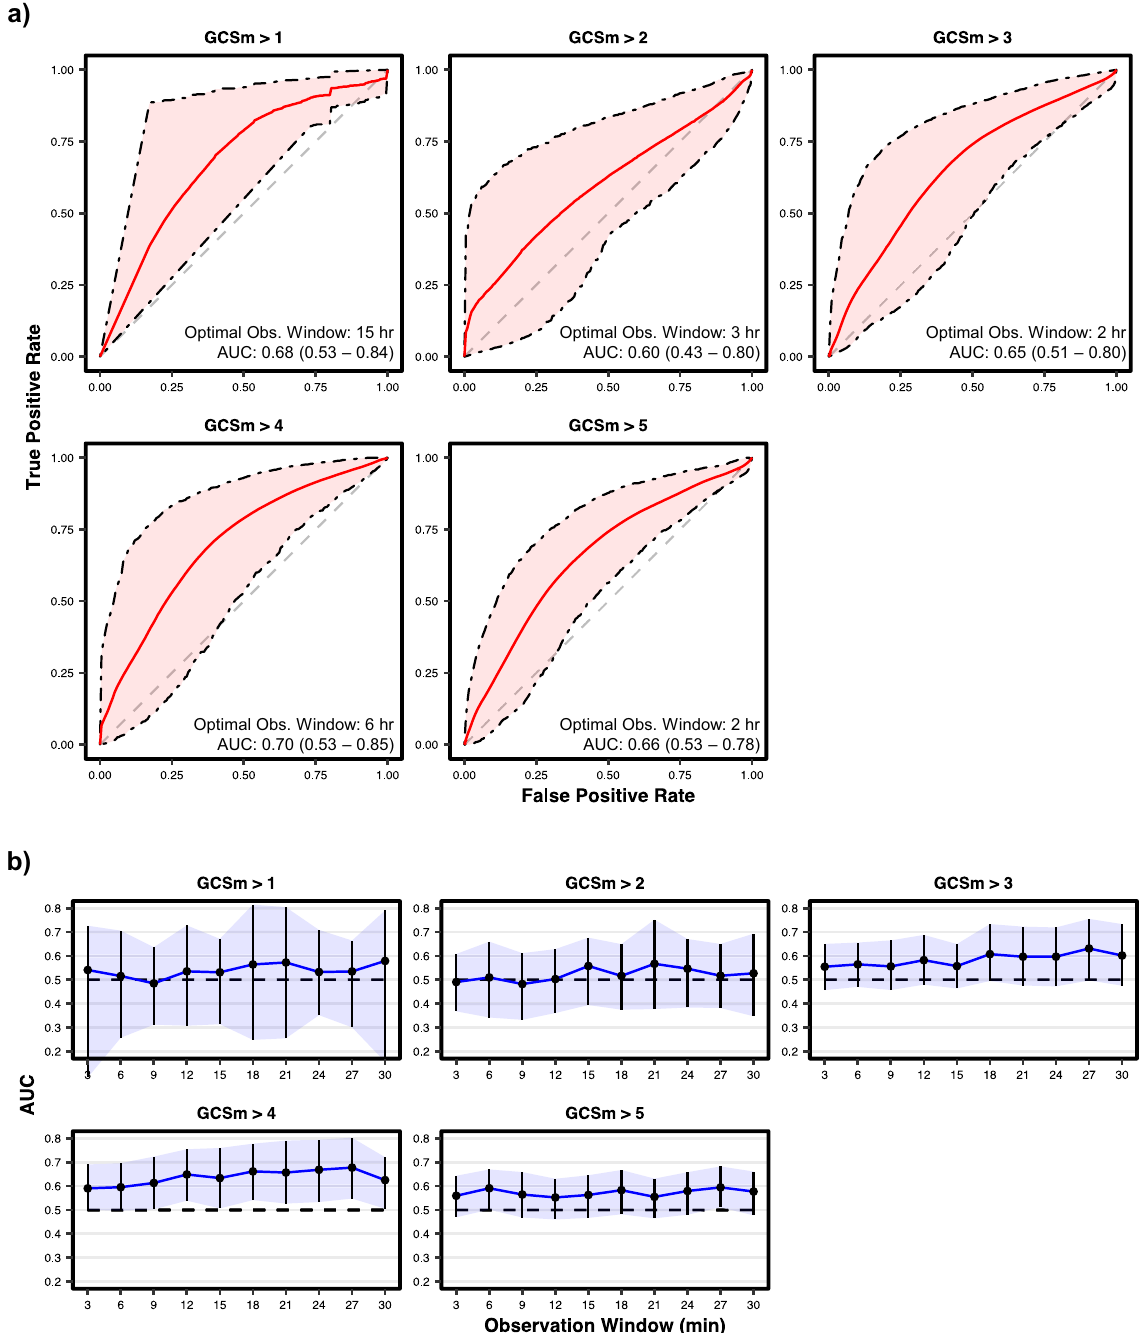
Figure 2. Discrimination performance of motor function detection models on validation sets. ( a ) Receiver operating characteristic (ROC) curves of models pertaining to the observation windows with the highest achieved area under the ROC curve (AUC) per each detection threshold of the motor component score of the Glasgow Coma Scale (GCSm). AUC corresponds to the probability that the model can correctly discriminate a randomly selected patient above the threshold from a randomly selected patient below the threshold. Shaded areas are 95% confidence intervals derived using bias-corrected bootstrapping (1000 resamples) to represent the variation across repeated cross-validation folds (5 repeats of 5 folds) and nine missing value imputations. The values in each box represent the observation window achieving the highest AUC as well as the corresponding mean AUC (with 95% confidence interval in parentheses). The diagonal dashed line represents the line of no discrimination (AUC = 0.5). ( b ) AUC vs. observation windows up to 30 min per each detection threshold of the motor component score of the Glasgow Coma Scale (GCSm). Points represent observation windows tested and error bars (with the associated shaded region) represent the 95% confidence interval. The horizontal dashed line corresponds to no discrimination (AUC =